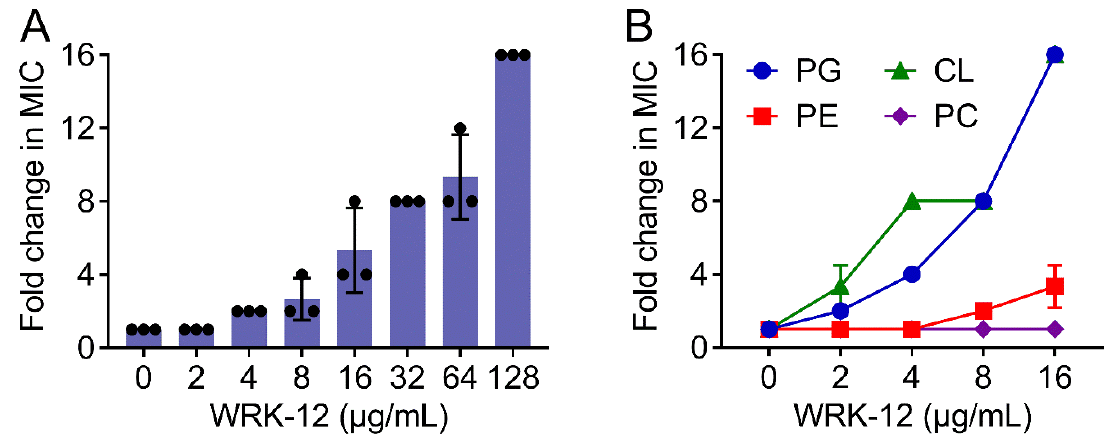
Figure 5. WRK-12 targets LPS and various phospholipids of the bacterial membrane. ( A ) Exogenous LPS from E. coli O111:B4 dose-dependent decreases the antibacterial activity of WRK-12 against E. coli 1F28, determined by chequerboard broth microdilution tests. ( B ) Exogenous lipids including PG, CL and PE except PC increase the MIC values of WRK-12 against E. coli 1F28, determined by chequerboard broth microdilution tests.